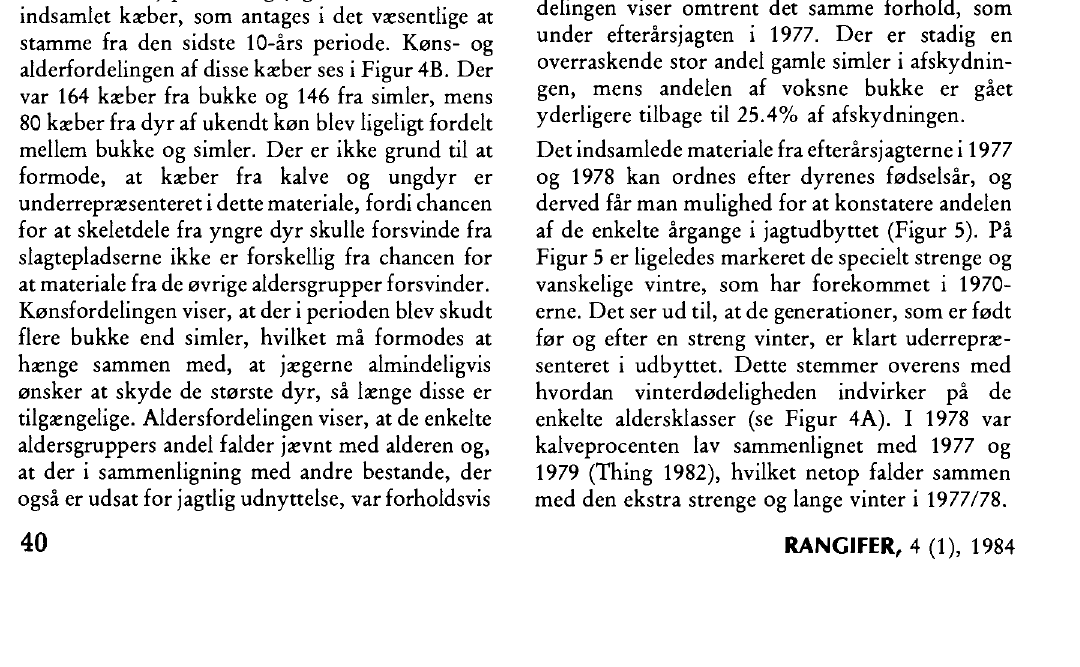
Fig. 4. Køns- og aldersfordeling af forskellige kæbe- materialer fra Sisimiut-bestanden. Sorte søjler = bukke, hvide søjler = simler, skraverede og prikkede søjleafsnit = ikke kønsbestemte dyr, som er skønsmæssigt fordelt mellem henholds vis bukke og simler. A = selvdøde dyr, B = tidligere skudte dyr, C = skudte dyr fra efteråret 1977, D = skudte dyr fra efteråret 1978. Fig. 4. Sex and age distribution of various materials of mandibles from the Sisimiut Population. Solid bars = bulls, open bars = cows, Hatched and dotted bar segments = non sexed animals, but divided between bulls and cows. A = starved animals, B = caribous shot previous to 1977, C = caribous shot autumn 1977, D = caribous shot autumn